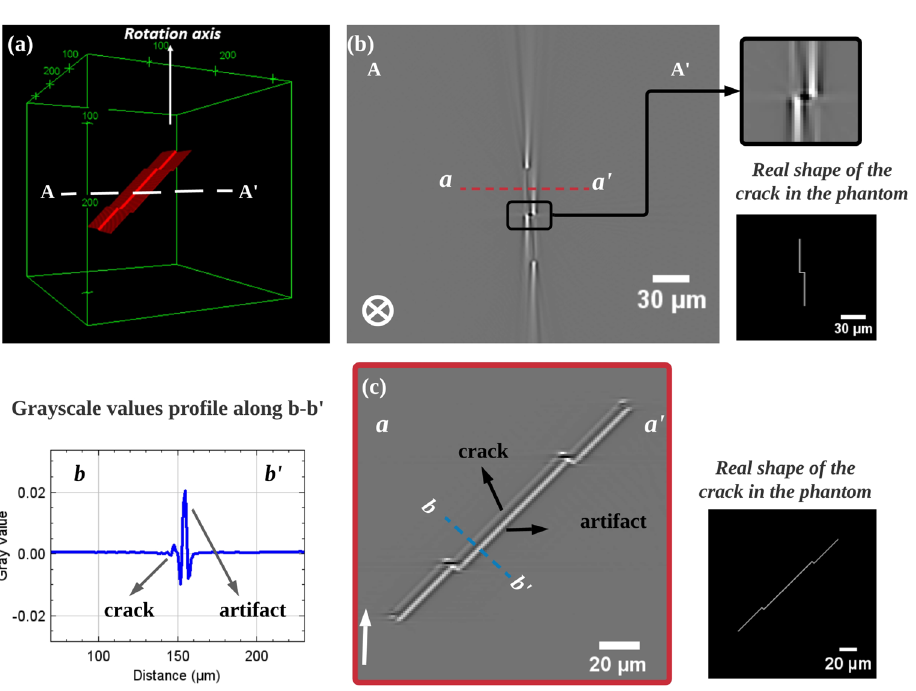
Figure 7. Simulation result of step-like crack (the step size is smaller than in the case of Fig. 6), scan conditions is the same as in Fig. 2: ( a ) Phantom’s 3D rendering, the white dashed line AA ′ indicate the position of the horizontal slice; ( b ) Horizontal slice (A–A ′ ) of the step-like crack, the red dashed line (a–a ′ ) mark the positions of the vertical slices ( c ), and the shape corresponding to the cracks is shown next to this image; ( c ) Vertical slices of the step-like crack along dashed red line in ( b ), the shape corresponding to the cracks is shown next to this image and the distribution of gray-scale values along the dashed line is displayed on the left side of the current image, ↑ and (cid:31) indicate the rotation